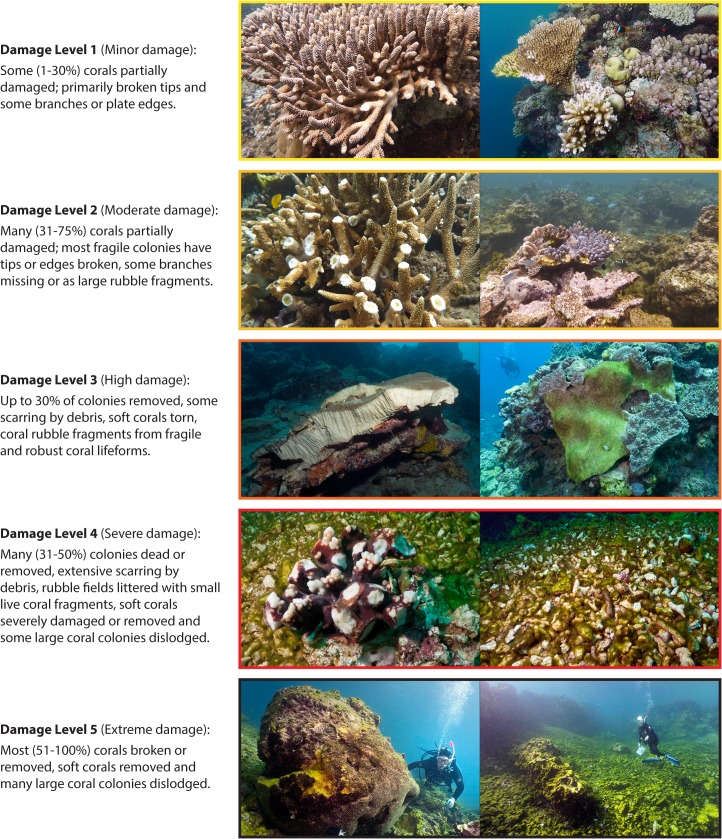
Representative photos of the 5 damage levels used in the impact assessment and analysis.The damage levels used follow the matrix in Fig. 3, which combines damage extent with the dominant type of colony-level damage observed.